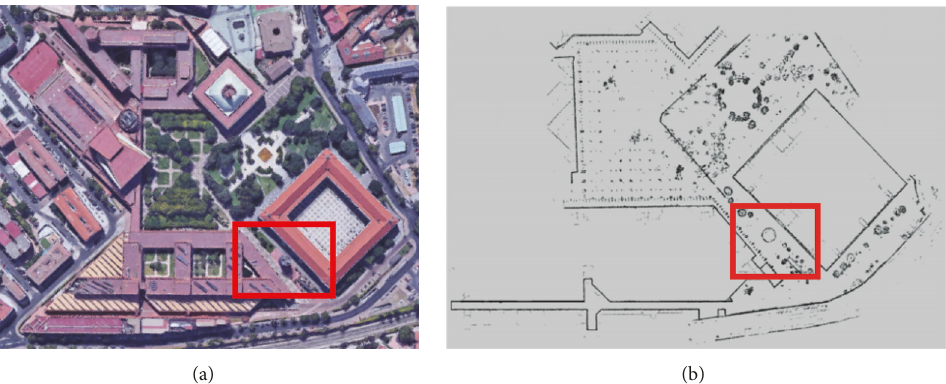
Figure 8: Satellite image of the Campus granted by Google Maps on (a). Campus gridmap on (b), the experiment is located inside of the red square.